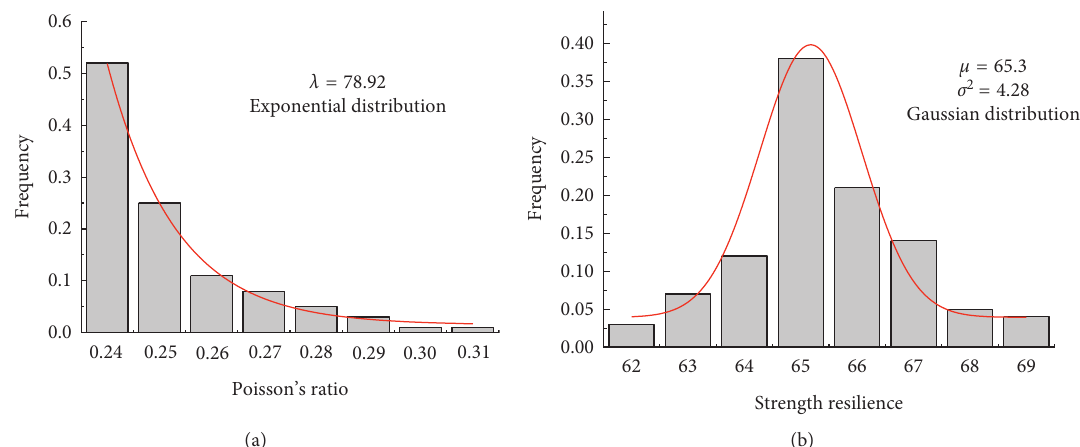
Figure 6: Statistics of partial classification indicators of K94 +713 ∼ 743.